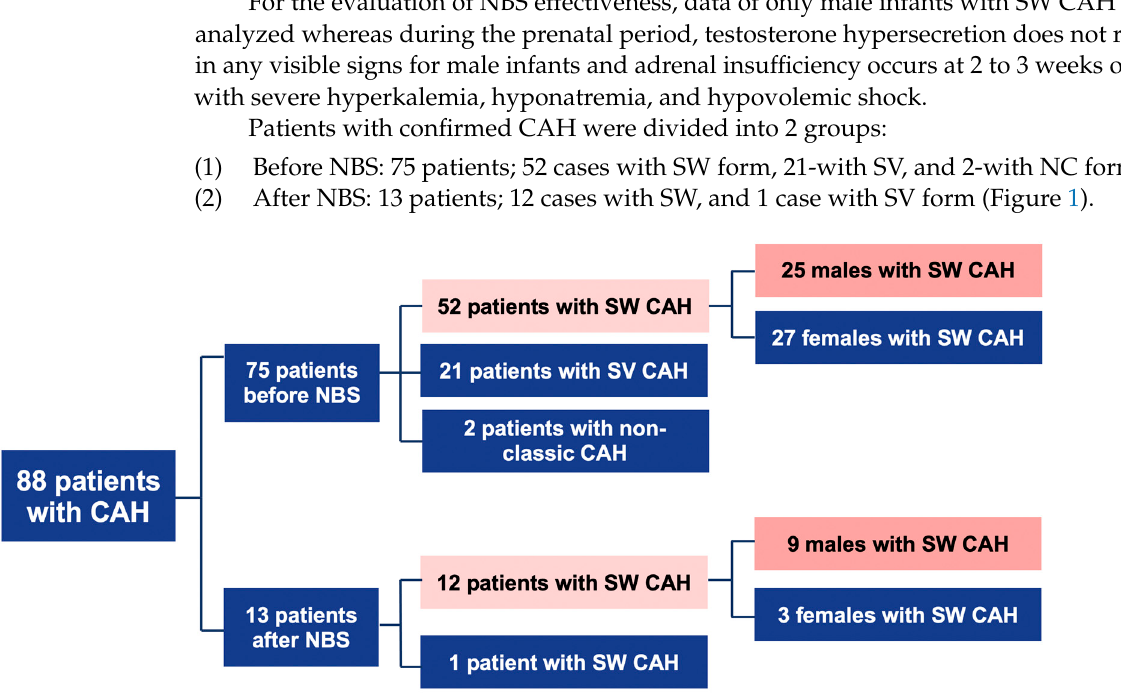
Figure 1. Descriptive scheme of cases. CAH: congenital adrenal hyperplasia; NBS: newborn screening; SW: salt-wasting; SV: simple